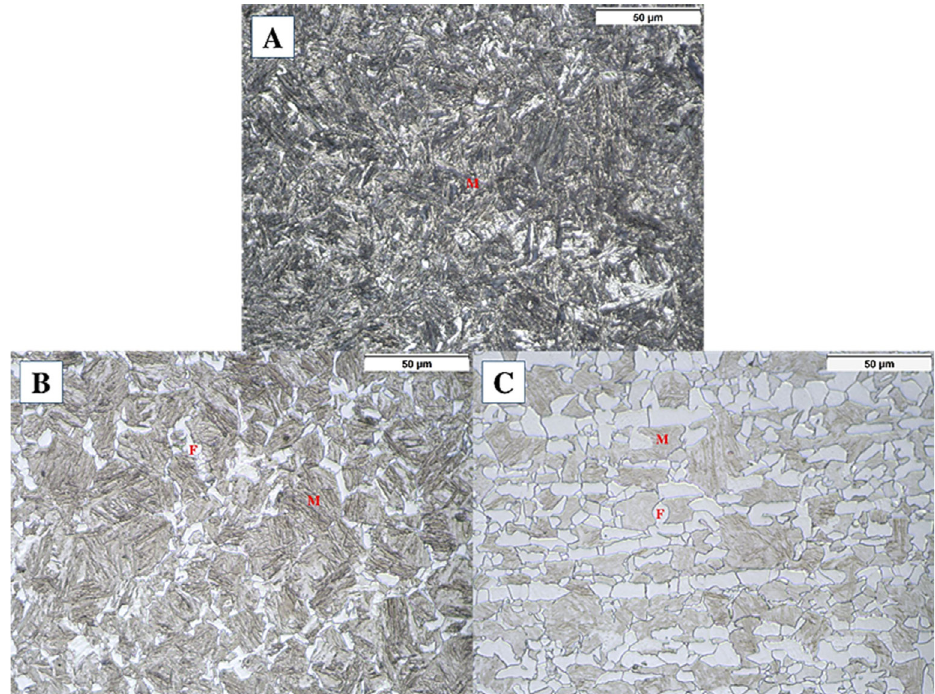
Figure 2. Microstructures of TRIP780 steel specimens submitted to Step Quenching heat treatment in isotherms: A) 800°C; B) 750°C; C) 700°C. F: Ferrite; M: Martensite - OM-500x - 4% Nital etching.